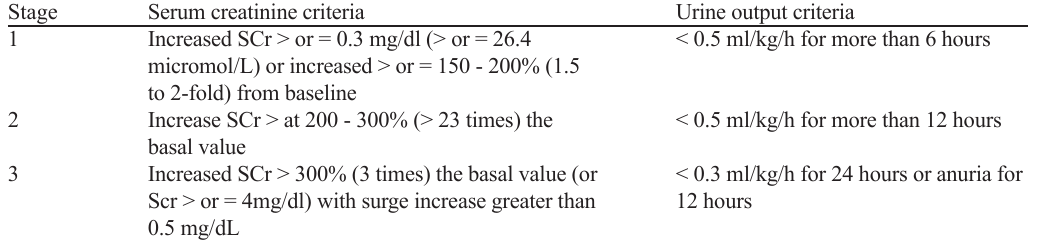
Table 2. AKIN classification.